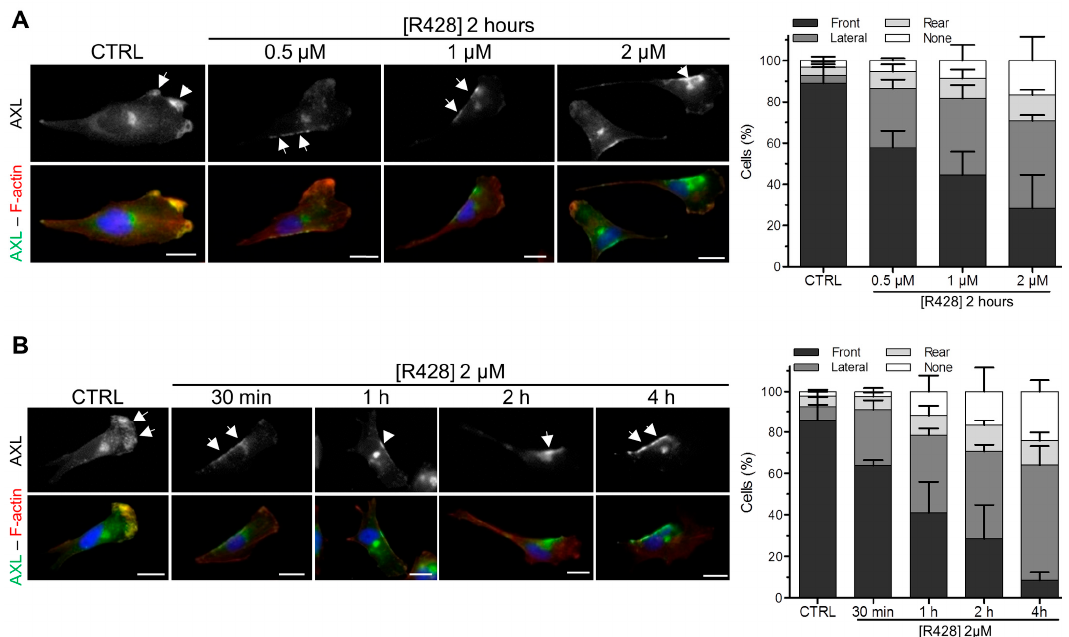
Figure 3. The inhibition of AXL disrupts its localization at the front of migratory cells. ( A ) Hs578t cells were treated with DMSO (CTRL) or various concentrations (0.5, 1 or 2 µM) of R428 for 2 h prior AXL (green) and F-actin (red) staining (left panel). Quantification of the cells (%) presenting a localization of AXL at the front, at the lateral area or at the rear in DMSO- or R428-treated cells (right panel) obtained from 183, 208, 176 and 218 cells in three independent experiments, respectively. ( B ) Hs578t cells were treated with DMSO (CTRL) or 2 µM of R428 during 30 min, 1 h, 2 h or 4 h prior AXL (green) and F-actin (red) staining (left panel). Quantification of the cells (%) presenting a localization of AXL at the front, at the lateral area or at the rear in DMSO- or R428-treated cells for 30 min, 1 h, 2 h or 4 h (right panel) obtained from 216, 181, 190, 218 and 217 cells in three independent experiments, respectively. Arrows point to AXL enriched localization. Scale bars, 20 µm. All graphs represent means and small bars indicate standard deviation.